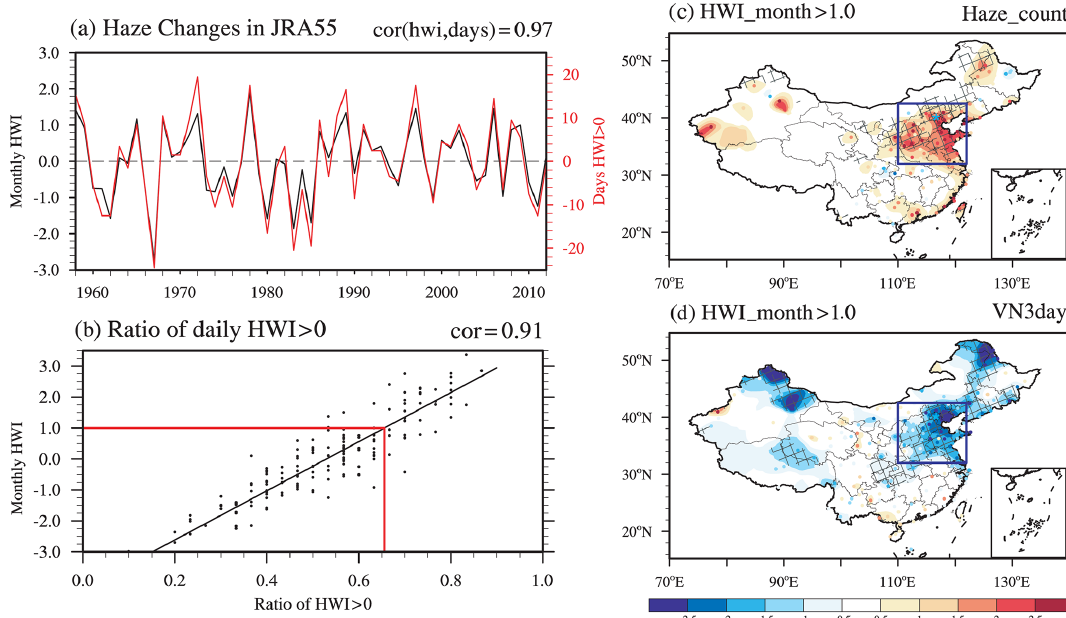
Figure 2. Changes in winter HWI from 1958 to 2013 in JRA-55 reanalysis relative to 1958–2013 winter mean. (a) DJF mean monthly-based HWI (HWI-month, black line) and the anomalous days with daily based HWI > 0 (HWI-daily; red line; unit: day); (b) scatterplot of HWI- month of December, January and February ( y axis) and the ratio of days with HWI-daily > 0 ( x axis) in each winter month. HWI-month and HWI-daily are the HWI calculated from monthly data and daily data, respectively. Panels (c–d) show the anomalies of haze occurrence and the VN3day when HWI ≥ 1, where VN3day is the minimum 3d consecutive visibility. Hatched area in (c–d) is statistically significant at the 10% level using a Student’s t test.